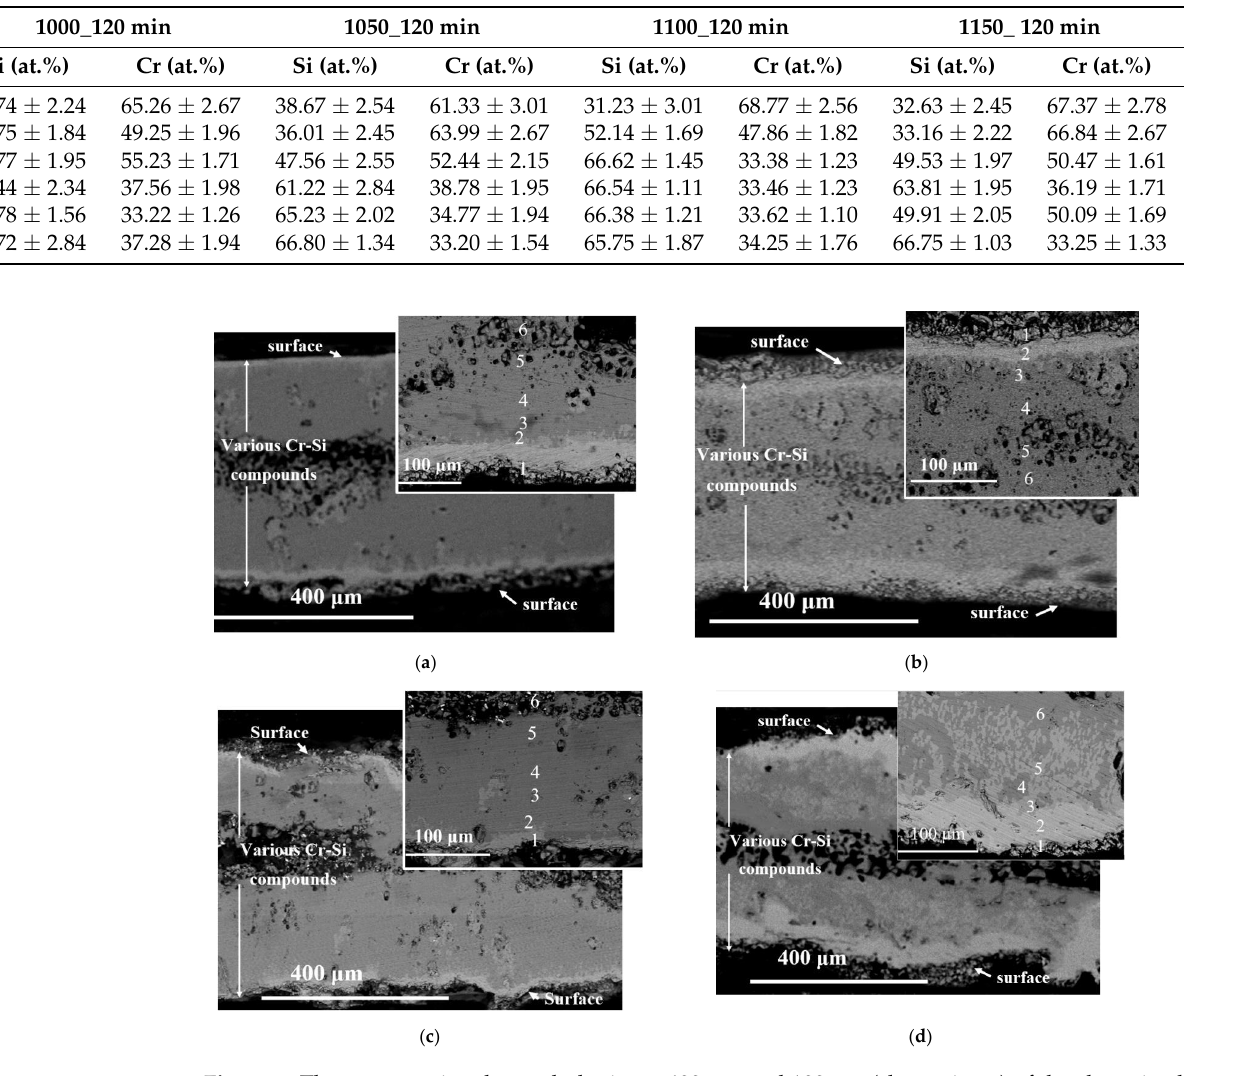
Figure 3. The cross-sectional morphologies at 400 μ m and 100 μ m (shown inset) of the chromized samples obtained by using 40 wt.% Cr in the pack mixture for 120 min at ( a ) 1000 °C; ( b ) 1050 °C; ( c ) 1100 °C; ( d ) 1150 °C. The areas denoted as #1, #2, #3, #4, #5, and #6 correspond to the EDS analysis presented in Table 2.